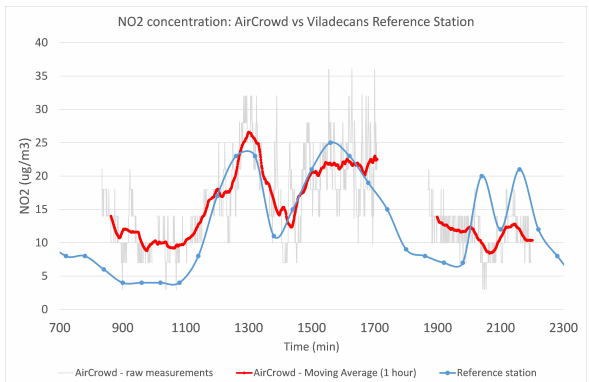
Figure 5. NO2 concentration: AirCrowd sensor node vs Reference station measurements along 20